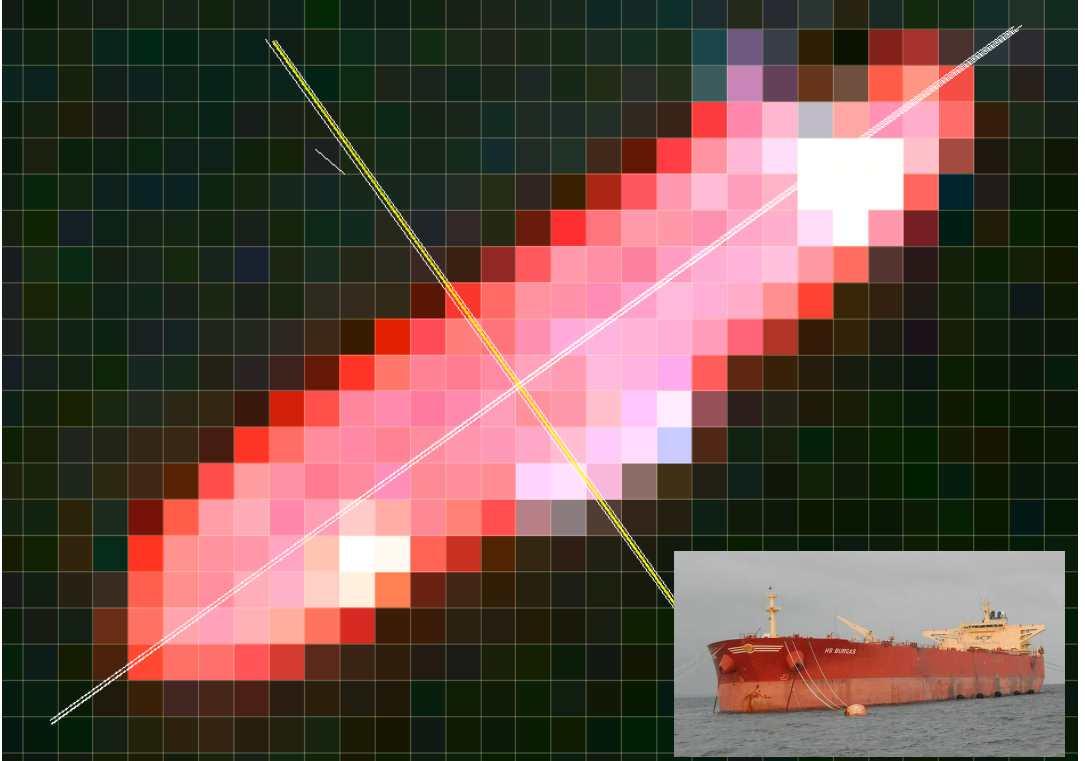
Figure 2. The RGB ship image box of NS Burgas (see Table 1, also present in Figure 1). Multiplying the pixels (i,j) by l = 10 m gives the ship coordinates (x,y). The axes show the ship axis coordinate system (x’,y’). Insert shows a horizontal visual image of the ship (with a substantially higher pixel resolution). The ship images contains reflectances I c (i,j) for each of the multispectral bands (c). The pixel coordinates ( i , j ) are the ( x , y ) coordinates in units of the pixel resolution l, which is l = 10 m for the blue, green, red and near-infrared bands c = B2, B3, B4, and B8, respectively, but l = 20 m for the bands c = B5, B6, B7, B8a, B11, B12, and l = 60 m for c = B1, B9, B10. The total ship reflectivity in spectral band c is: